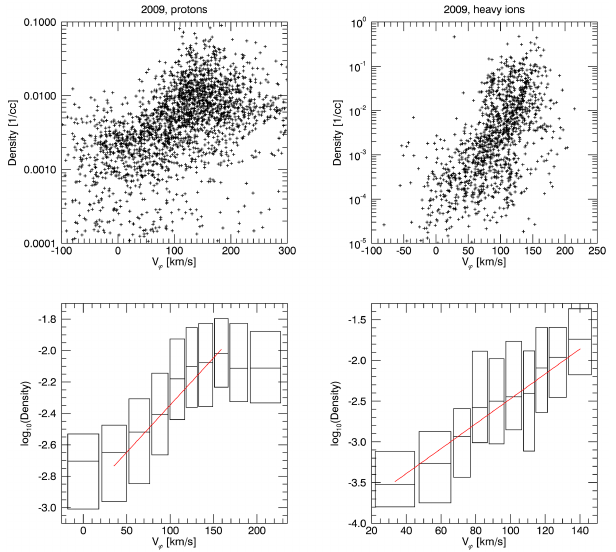
Figure 2. Azimuthal velocity – density relationship. The left panels show proton data, the right panels show water-group data, measured in the nightside outer magnetosphere of Saturn in year 2009. Upper panels: scatter plots, bottom panels: box-plots. The three horizontal lines of each box represent the first, second and third quartiles of the corresponding bin. There is an equal number of points in each bin, this is why the width of the bins vary. The red line is a linear fit for the mean values of the bins it crosses.